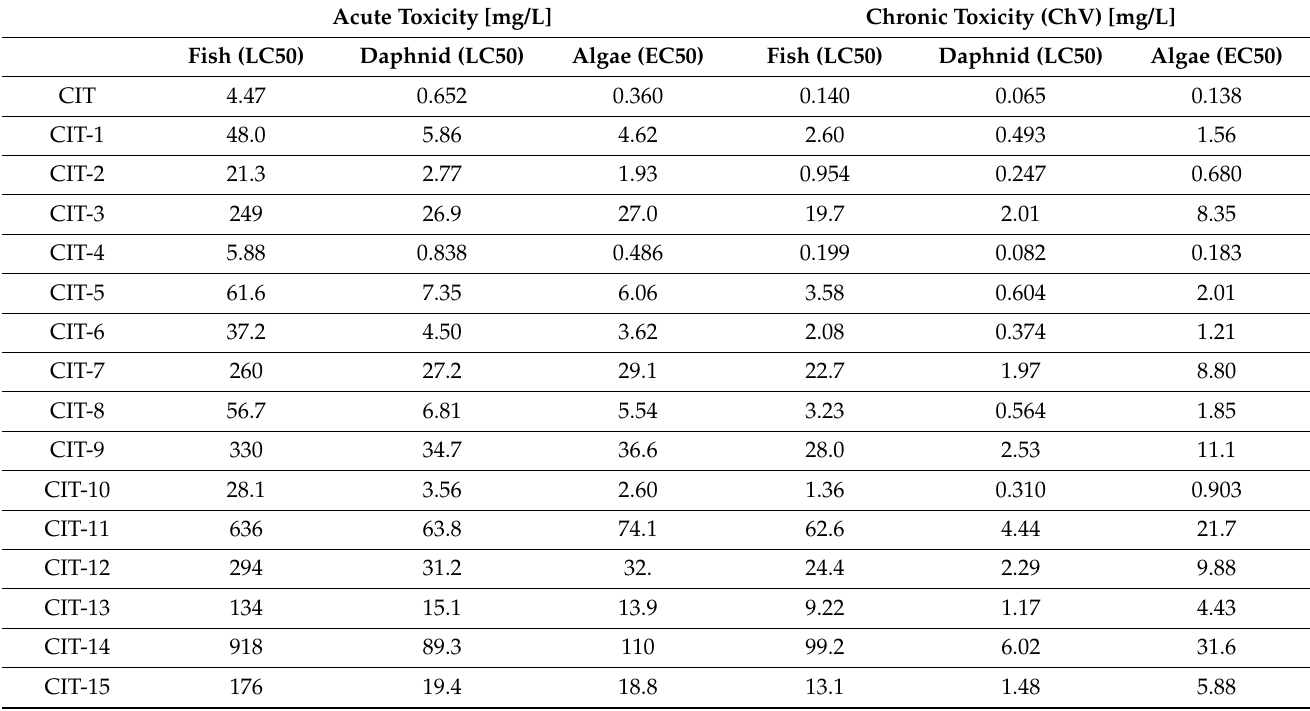
Table 7. Toxicity predictions for CIT and its transformation products using ECOSAR